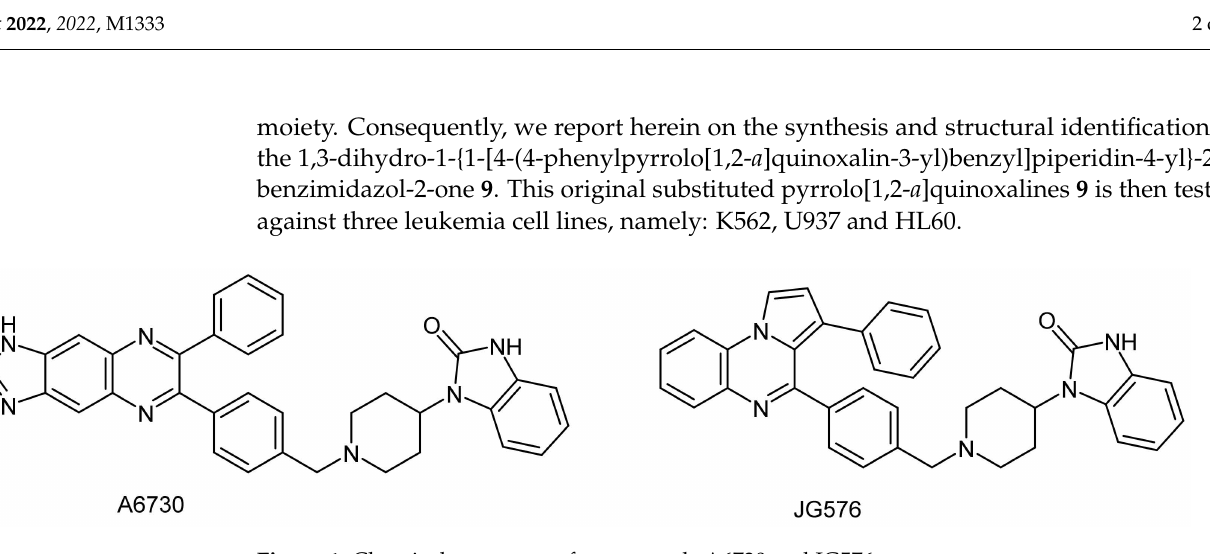
Figure 1. Chemical structures of compounds A6730 and